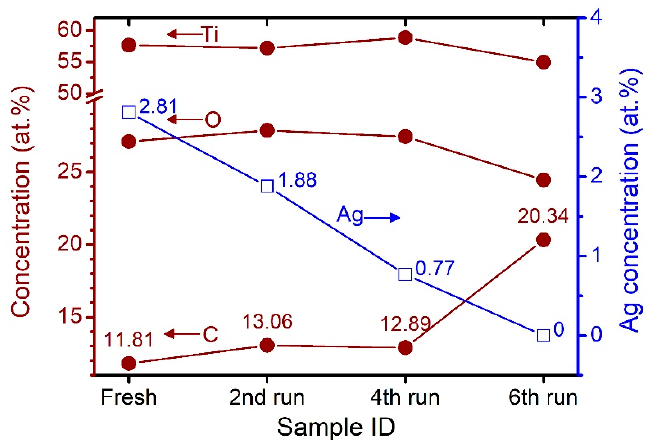
Figure 9. Ti, O, Ag, and C atomic concentrations determined by XPS for fresh and recycled TiO 2 NTs/Ag catalysts (up to 6th run).